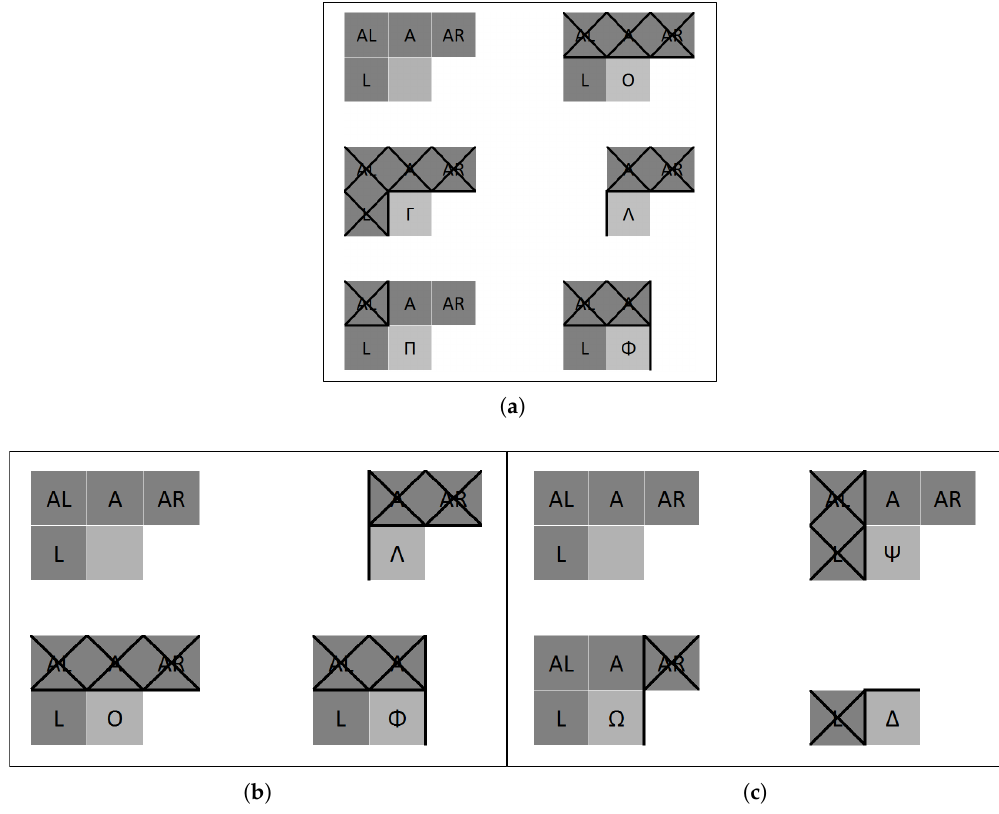
Figure 6. Searching area to perform the CTU prediction depending of the position of the borders in a